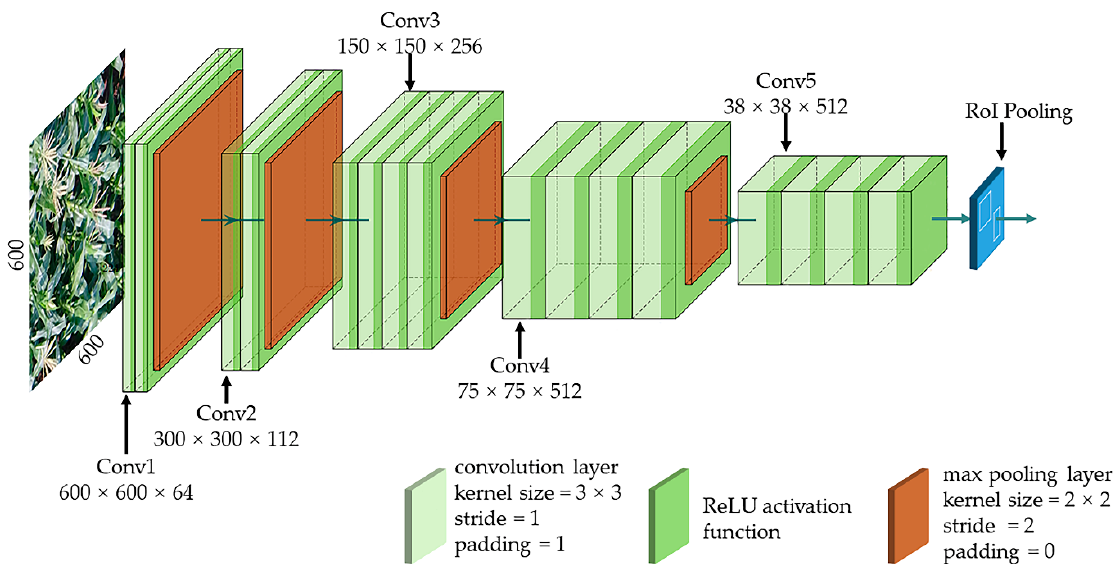
Figure 5. Extracted feature map using VGG19 with 600 × 600 resolution image. Conv represents convolutional neural network.